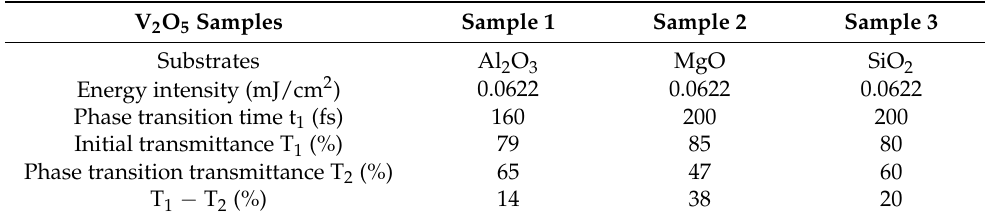
Table 1. Phase transition characteristics of V 2 O 5 thin films obtained by ultrafast pump–probe method.